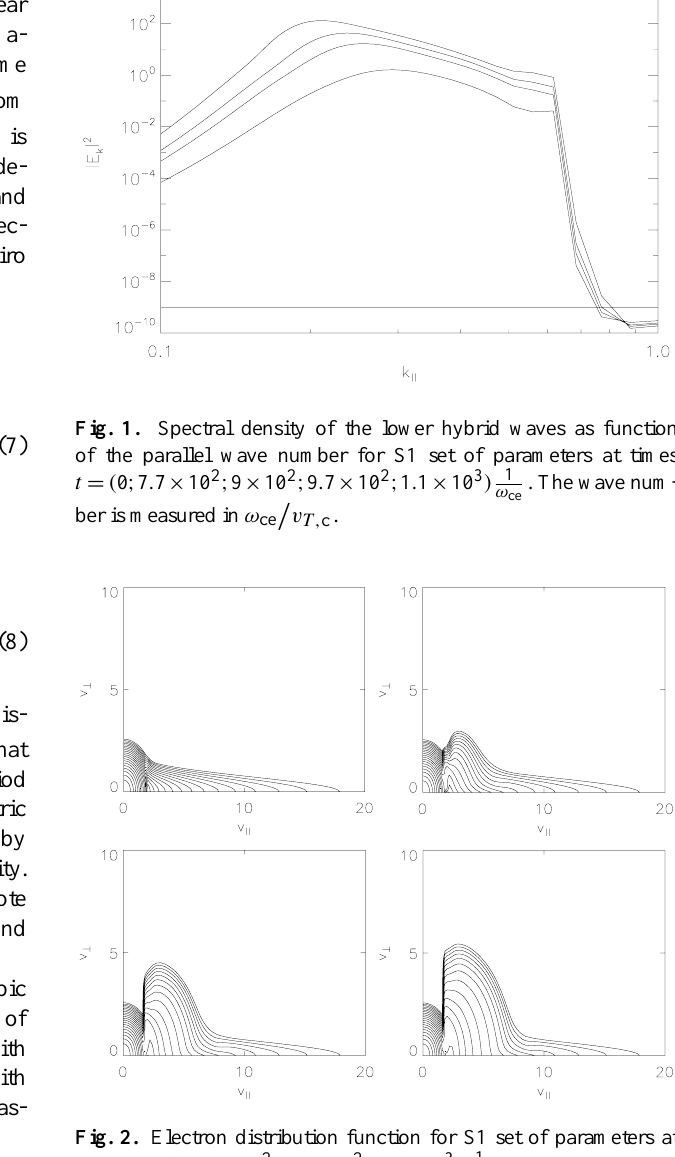
. Velocities are mea- ω ce